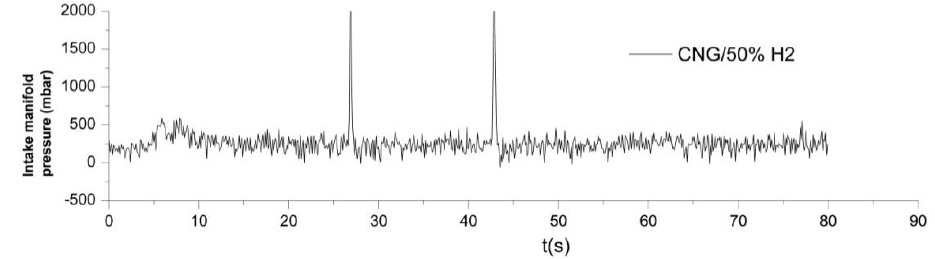
Figure 15. Intake manifold pressure profile for H 2 CNG50.